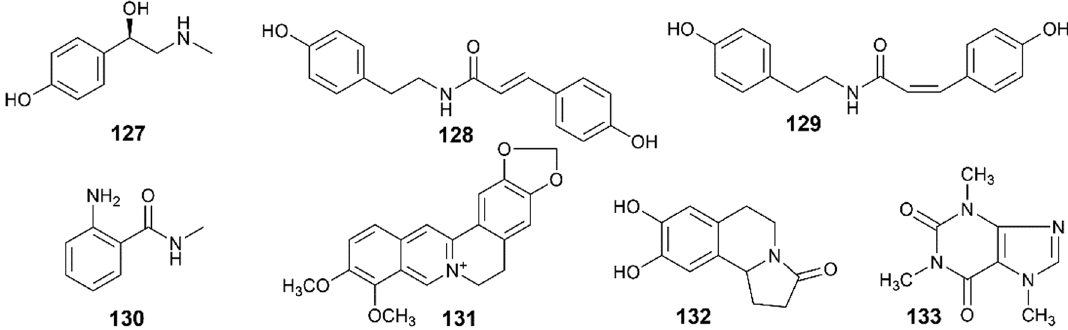
Fig. 4 Other alkaloids isolated from Euodiae Fructus